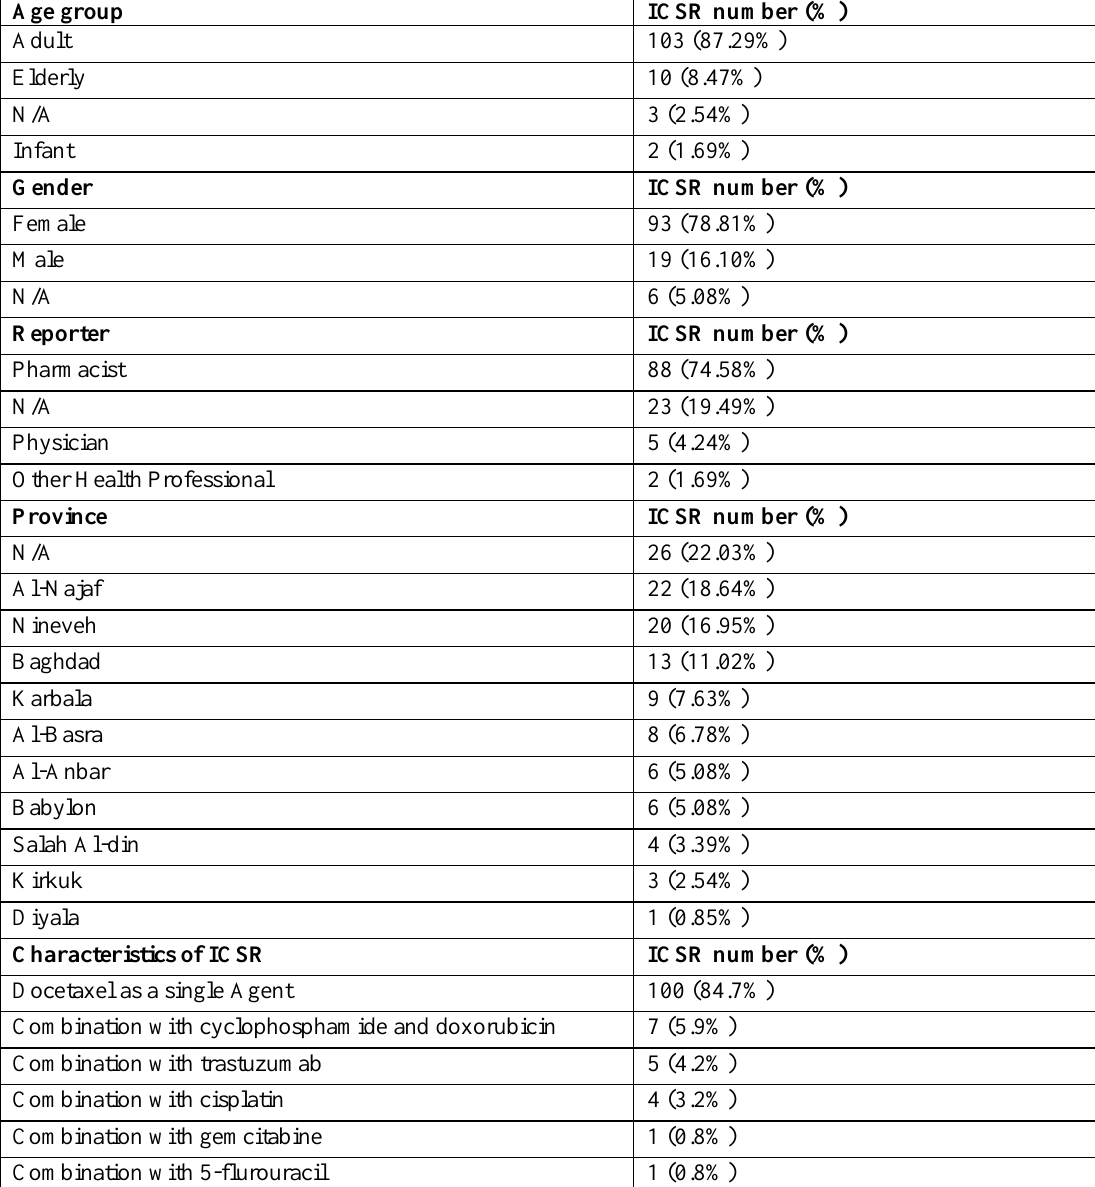
Table 5. Age group, gender, reporter and province distribution of